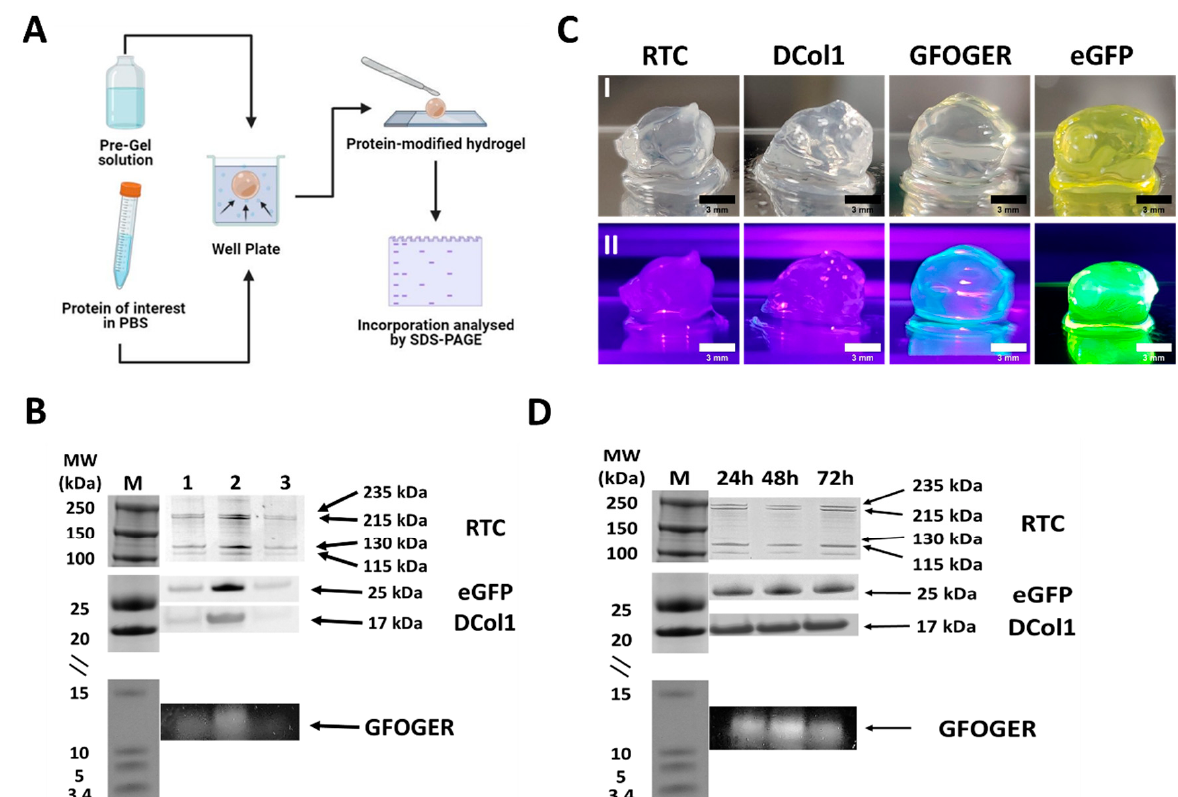
Figure 2. Hydrogel modification. ( A ) Schematic representation of the optimised protocol used to incorporate proteins within hydrogels. ( B ) SDS-PAGE analysis of the proteins incorporated into the Fmoc-FF/S hydrogels. Lanes: M, molecular weight markers; 1, protein stock solution; 2, protein incorporated into the hydrogel; 3, remaining protein into the well. Arrows (right) indicates protein bands at their corresponding molecular weights. ( C ) Photograph of spheroid-like hydrogels incorporating proteins under visible ( I ) and UV ( II ) light. ( D ) SDS-PAGE analysis of protein retention inside the hydrogels over time. Lanes: M, molecular weight markers; 1, 2, 3 show protein retention after 24, 48, 72 h, respectively. Arrows (right) indicates protein bands at their corresponding molecular weights.